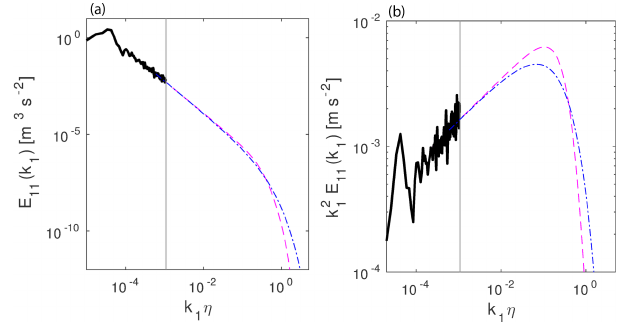
Figure 11. One-dimensional spectra: black solid line – measured part; dashed magenta line – recovered part with f η described by Eq. (23); dot-dashed blue line – recovered part with f η described by Eq. (24). (a) Energy spectrum E 11 (k 1 ) ; (b) k 2